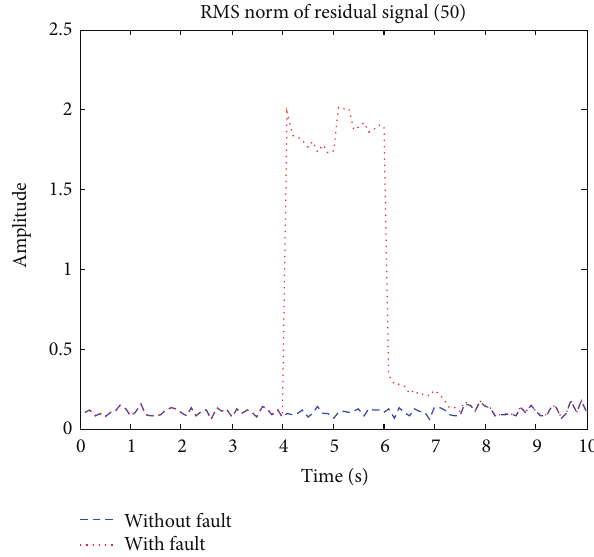
the data framework for designing unknown input observer for time-delay system is an interesting